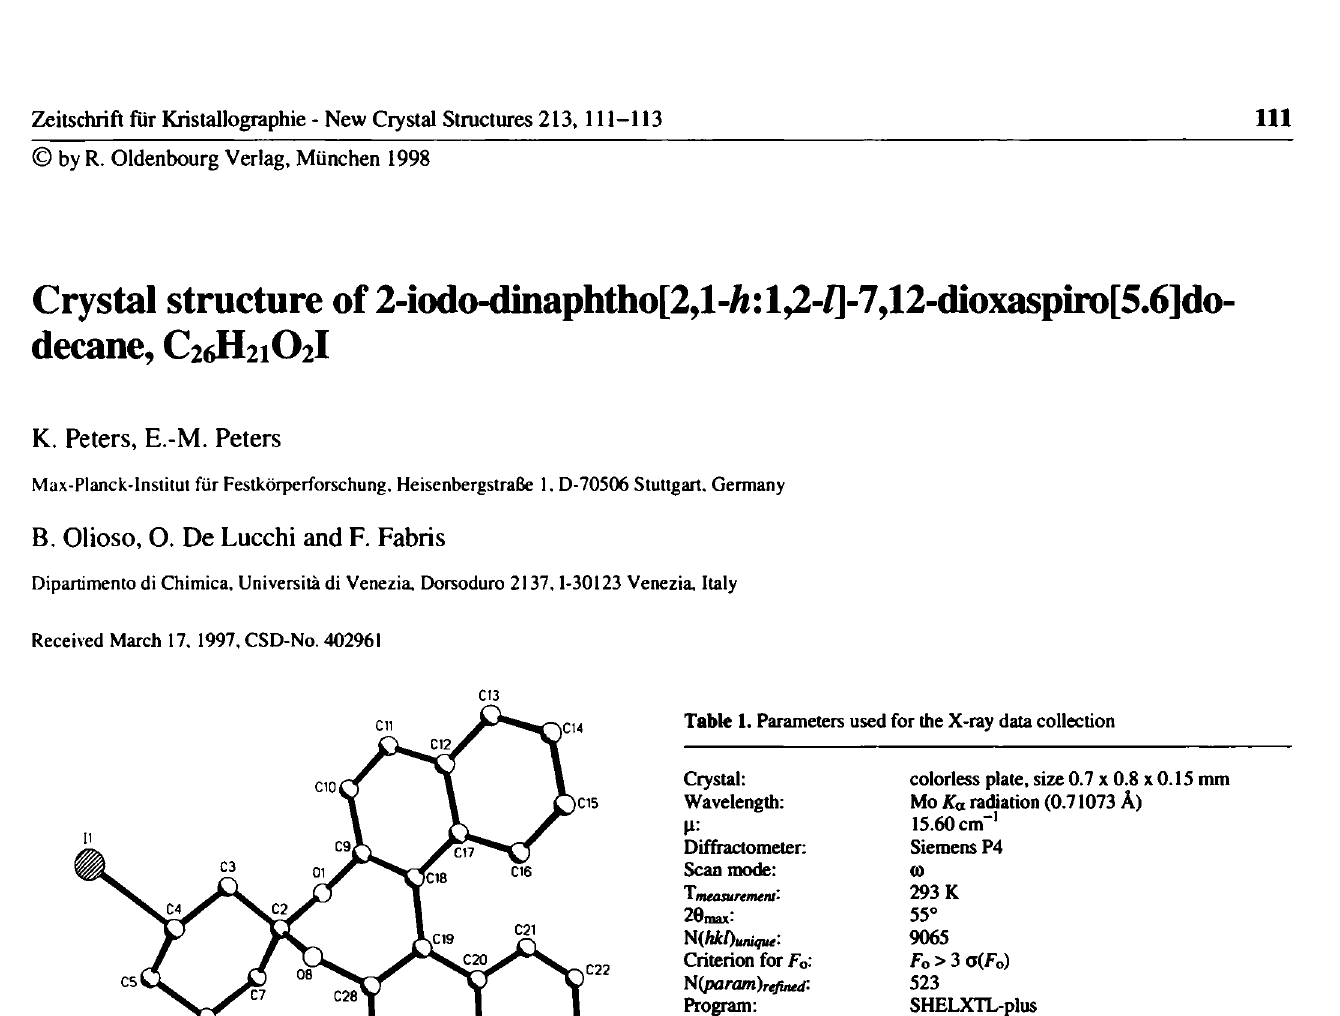
Table 2. Fmal atomic coordinates and displacement parameters (in